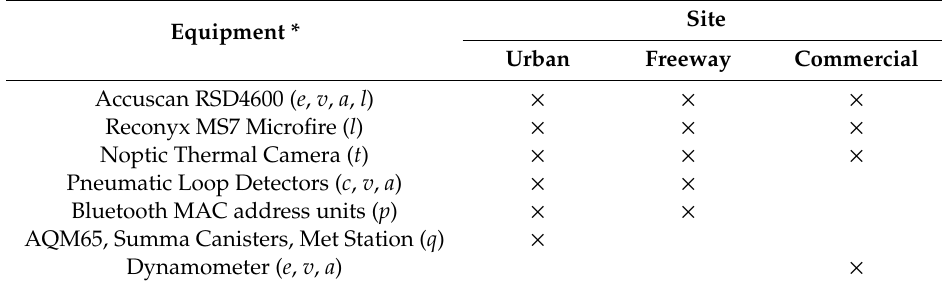
Table 1. Overview of equipment used at each measurement site. Equipment *